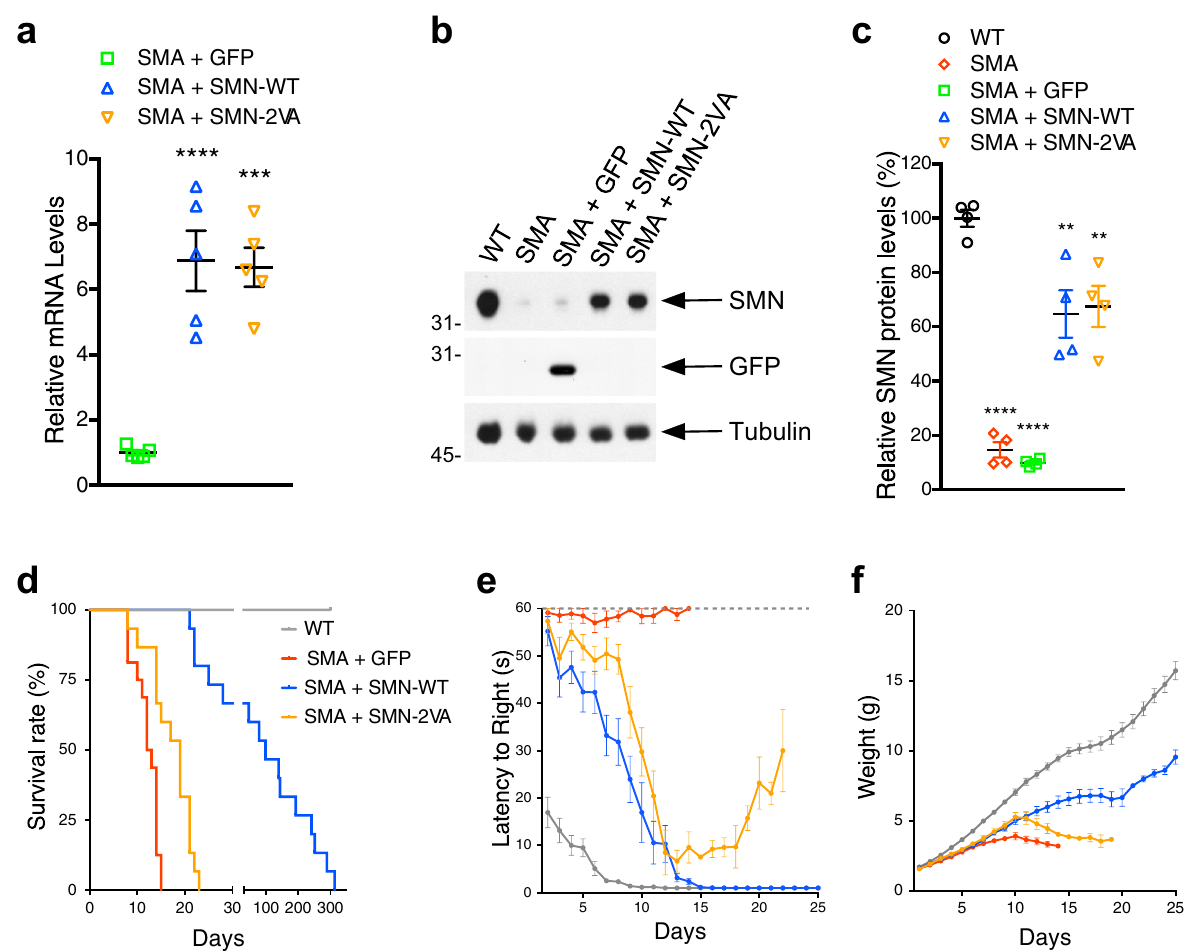
Fig. 6 SIM-less SMN gene delivery marginally improves survival and motor function of SMA mice. a RT-qPCR analysis of full-length human SMN mRNA in the spinal cord of SMA mice injected with AAV9-GFP, AAV9-SMN-WT or AAV9-SMN-2VA. Data represent mean and SEM ( n = 5 animals). Statistical signi fi cance was determined by one-way ANOVA with Tukey ’ s post hoc test (adjusted P values: SMA + GFP vs. SMA + SMN-WT p < 0.0001; SMA + GFP vs. SMA + SMN-2VA p = 0.0001; SMA + SMN-WT vs. SMA + SMN-2VA p = 0.9742. b Western blot analysis of GFP and SMN WT or 2 VA protein levels in the spinal cord of AAV9-injected SMA mice and uninjected WT controls at P9. Tubulin is used as loading controls. c Quanti fi cation of four independent Western blot experiments. Data represent mean and SEM ( n = 4). Statistical signi fi cance was determined by one-way ANOVA with Tukey ’ s post hoc test (adjusted P values: WT vs. SMA p < 0.0001; WT vs. SMA + GFP p < 0.0001; WT vs. SMA + SMN-WT p = 0.0032; WT vs. SMA +